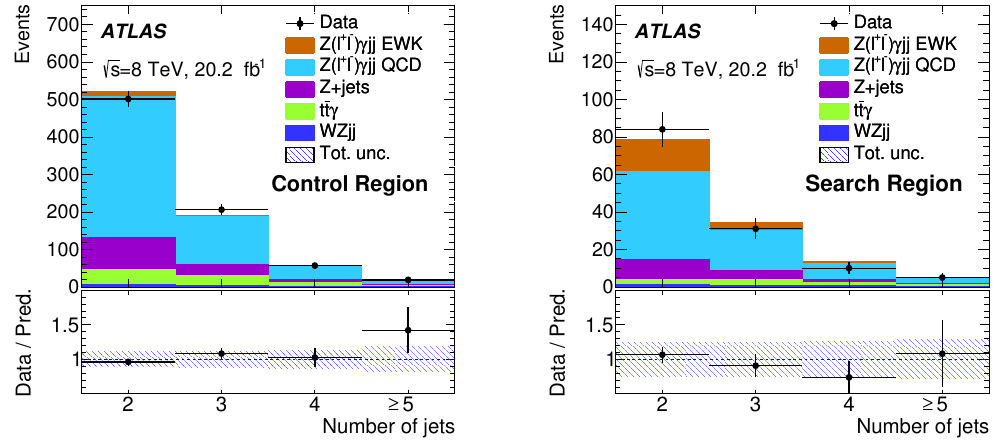
Figure 3 . Distributions of the number of jets passing the selection for the electron and muon channels added together in the control region (left) and in the search region (right), for the data (black points), and for the signal process and various background components (coloured templates) before any (cid:12)t is done. The ratio of the data to the sum of all pre-(cid:12)t expected contributions (\Pred.") is shown below each histogram. The hatched blue band shows the systematic and statistical uncertainty added in quadrature (\Tot. unc.") in the signal and background prediction, while the error bars on the data points represent the statistical uncertainty of the data set. The last bin also includes events beyond the range shown.